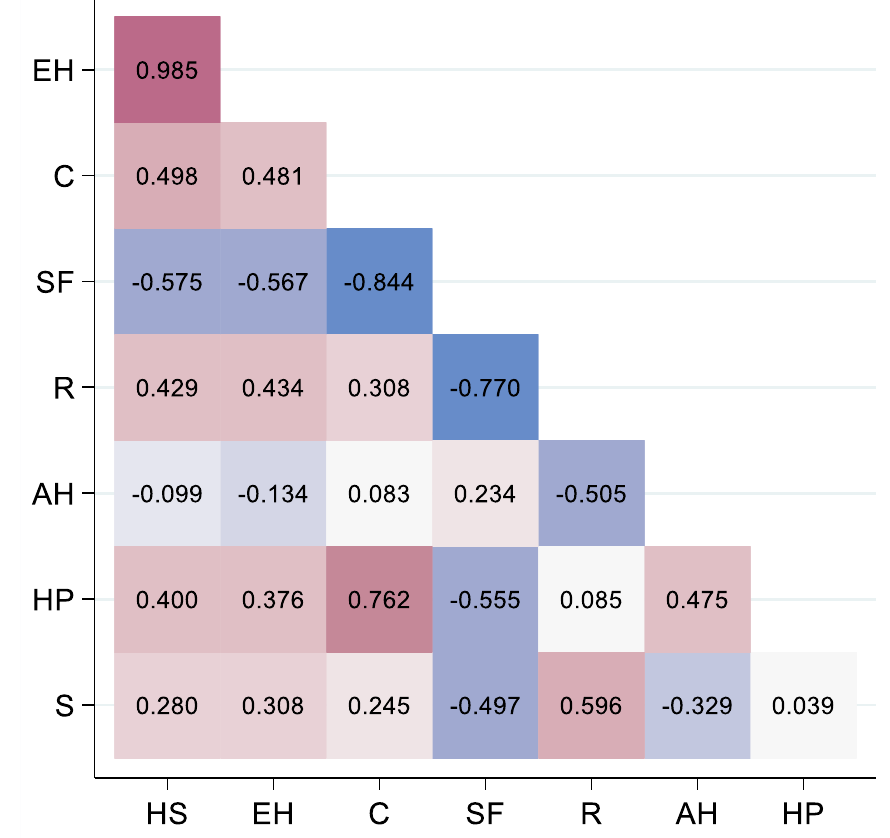
Figure 3. Correlation coefficients (housing variables). Note: Elderly Housing (EH), Condominium (C), Single-Family (SF), R(Rental), AH (Adults at Home), HP (House prices), and S (Segregation).